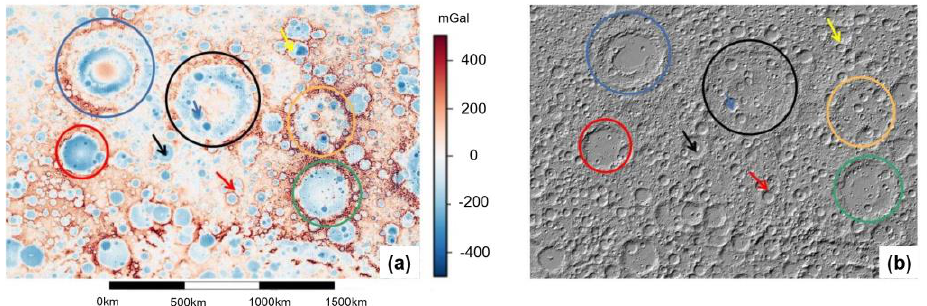
Figure 2. The comparison of different scale features showing on the map of the GRAIL gravity data ( a ) and LRO data ( b ) (The circles mean the large features, and the arrows mean the small features). The processing data sets are formed by manually delineating the gravity anomalies of impact craters in the GRAIL gravity map. The position and morphology of the anomaly are determined by two points. One is the coordinate of the center of the anomaly, and the other is one point on the edge of the anomaly. Anomalies caused by independent and well-characterized impact craters can be delineated manually. However, for those areas that have been subjected to multiple meteorite impacts, multiple superimposed anomalies need to be compared with high-precision DEM images before delineation, which is more dependent on the operator’s subjective experience. In addition, due to the image accuracy, some gravity anomalies with pixel diameters less than 6 pixels are difficult to reflect the above features, so they are temporarily omitted. The source data can be added to further improve model performance after the accuracy of the source data is improved. After man- ual detection and delineation after above considerations, a total of 910 usable anomalies were identified, classified by diameters as shown in Table 1. Table 1. The information of known usable anomalies in the data sets. The Diameter of Known Usable Anomalies The Numbers of Known Usable Anomalies <25